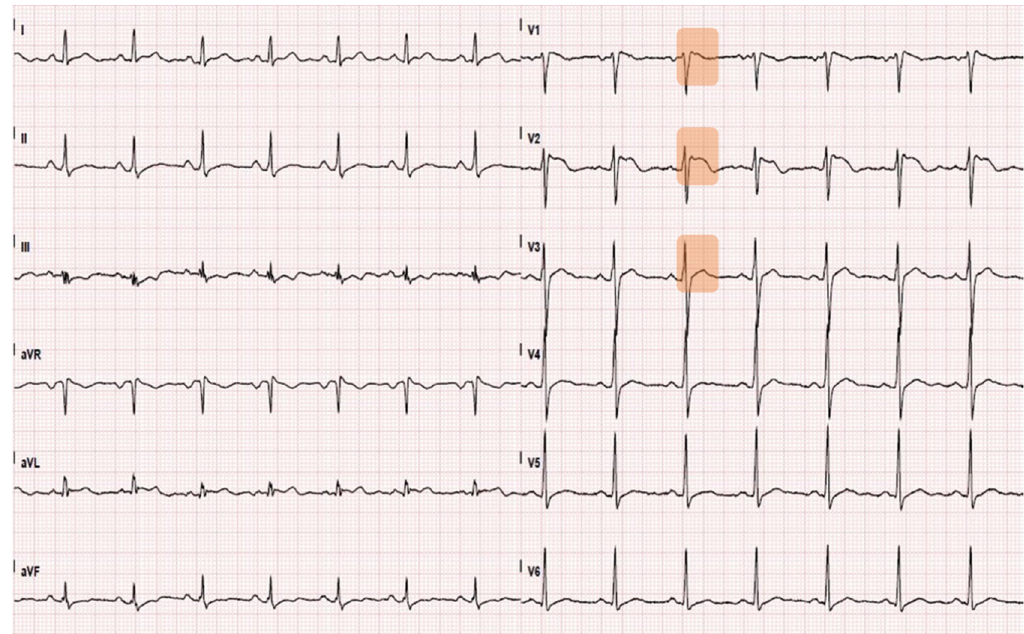
Figure 1. Electrocardiogram on admission showing a Brugada type II pattern (saddleback shaped ST elevation in V1–V3, examples highlighted).